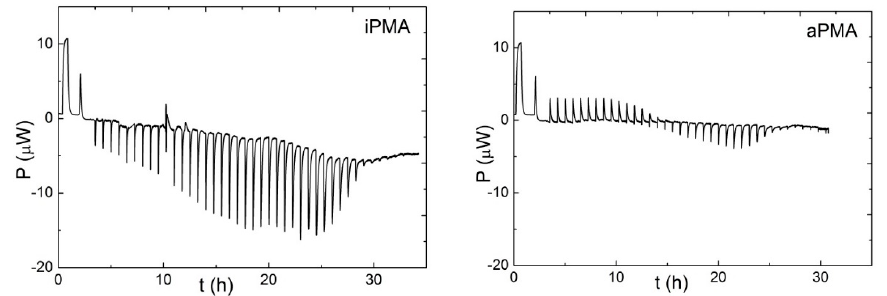
Figure 1. Raw ITC data (power, P , in μ W) obtained from injections of 5 μ L aliquots of 0.06 M HCl into 2 mL of 0.01 M iPMA ( left ) or aPMA ( right ) in 0.01 M aqueous LiCl solutions at 25 °C. The first peak in both thermograms corresponds to static and the second one to dynamic calibration. Subsequent peaks are due to the protonation reaction.